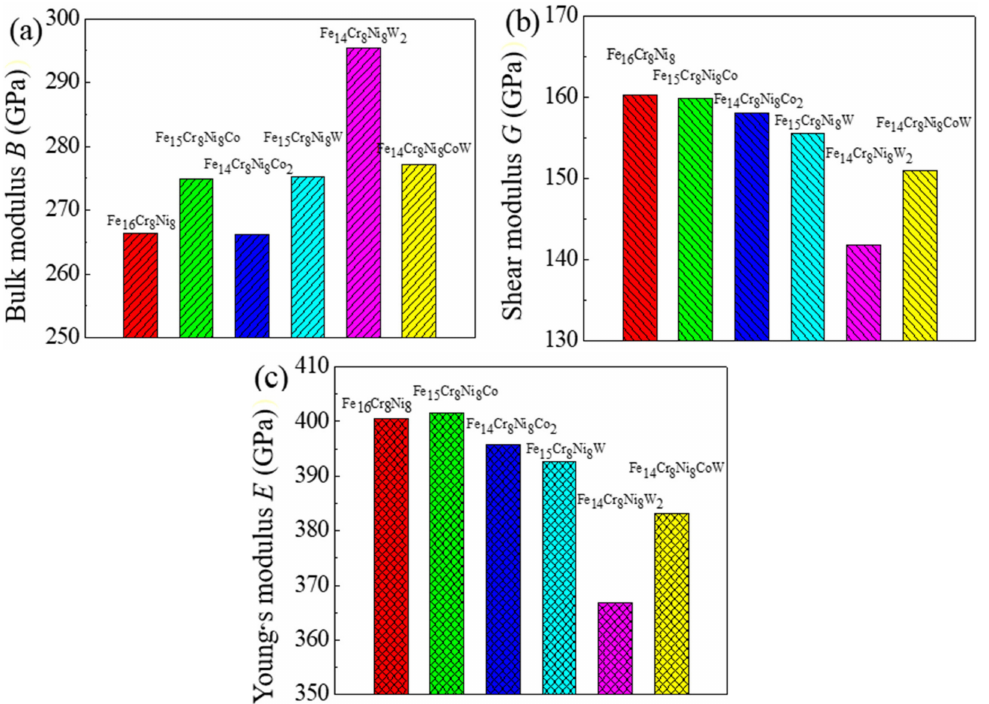
Figure 6. Calculated elastic modulus of di ff erent systems: ( a ) the bulk modulus B , ( b ) shear modulus G and ( c ) Young’s modulus E